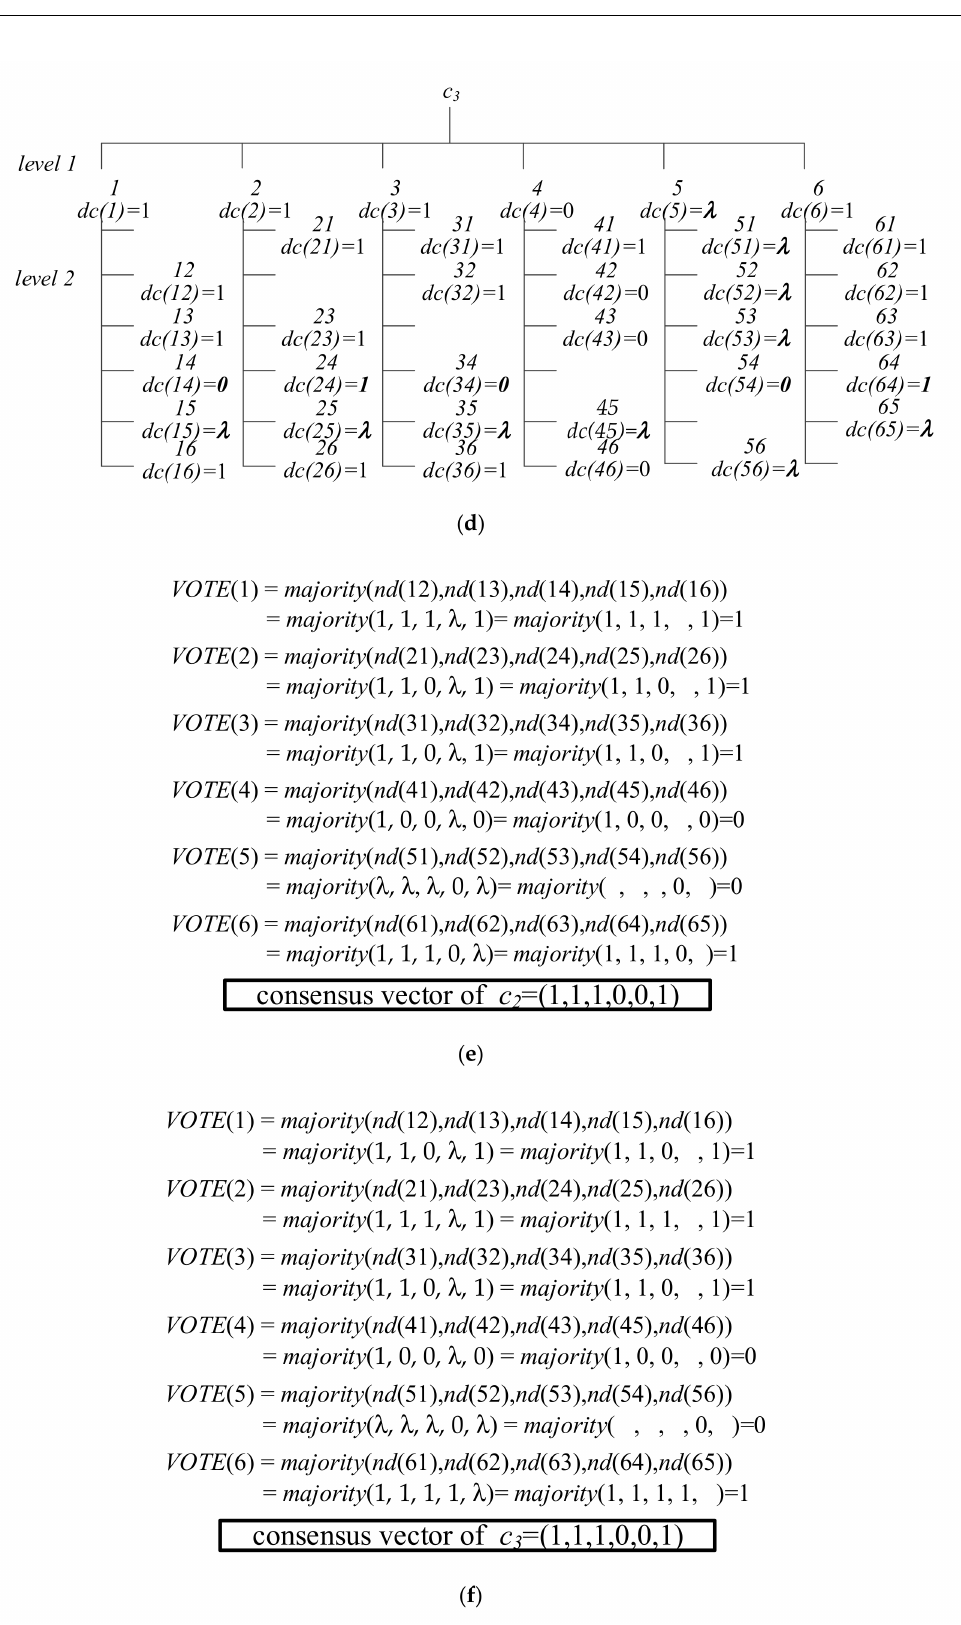
Figure 9. ( a ) The initial value of each Cloud PE of Cloud-layer. ( b ) The dg-graph of each Cloud PE in Cloud-layer during the first data exchange in the Data Gathering Stage. ( c ) The final dg-graph of c 2 during the second data exchange in the Data Gathering Stage. ( d ) The final dg-graph of c 3 during the second data exchange in the Data Gathering Stage. ( e ) The consensus vector of c 2 by Consensus Decision Stage. ( f ) The consensus vector of c 3 by Consensus Decision